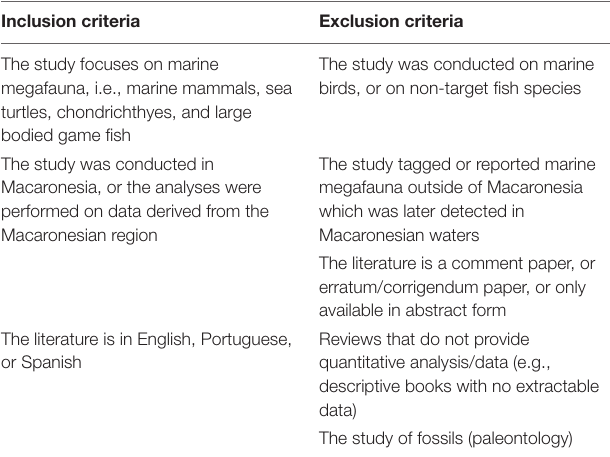
TABLE 2 | Inclusion and exclusion criteria for literature in the systematic